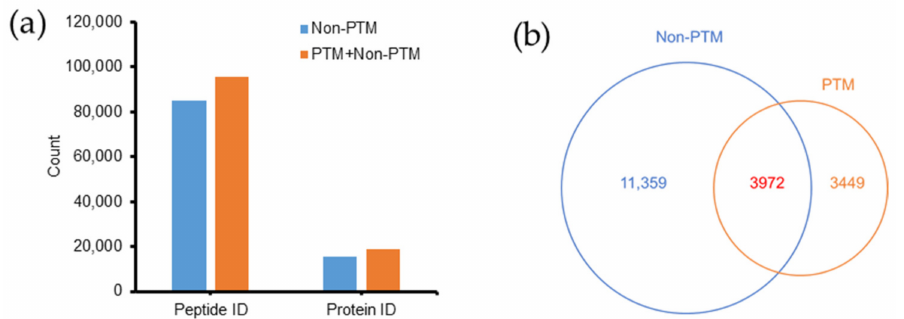
Figure 2. Effects of PTM search on peptide and protein identification in Emiliania huxleyi . ( a ) PTM search increased the number of peptides and proteins identified (IDs). ( b ) Comparison of proteins identified between non-PTM and PTM